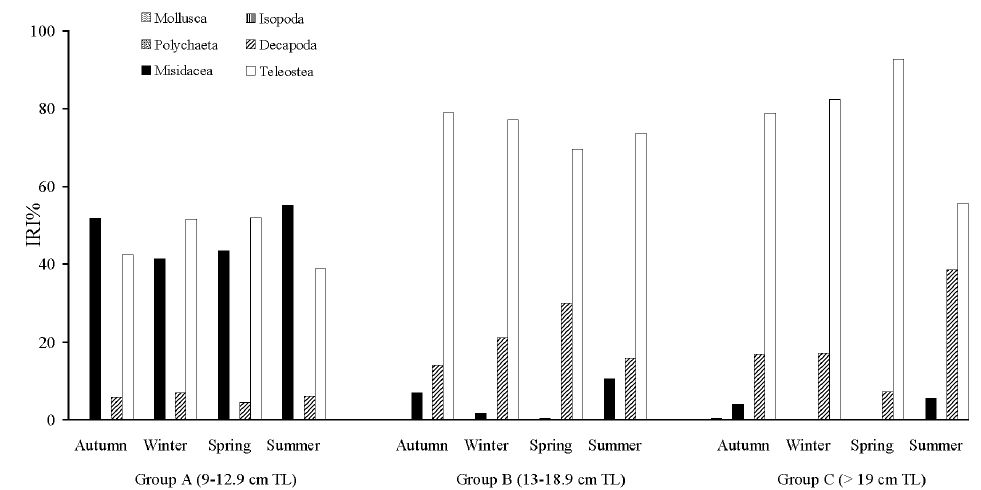
Fig . 4. – Seasonal variation in percentage abundance (IRI%) of the different prey items for the three spotted flounder size groups identified by the Cluster and NMDS analysis.